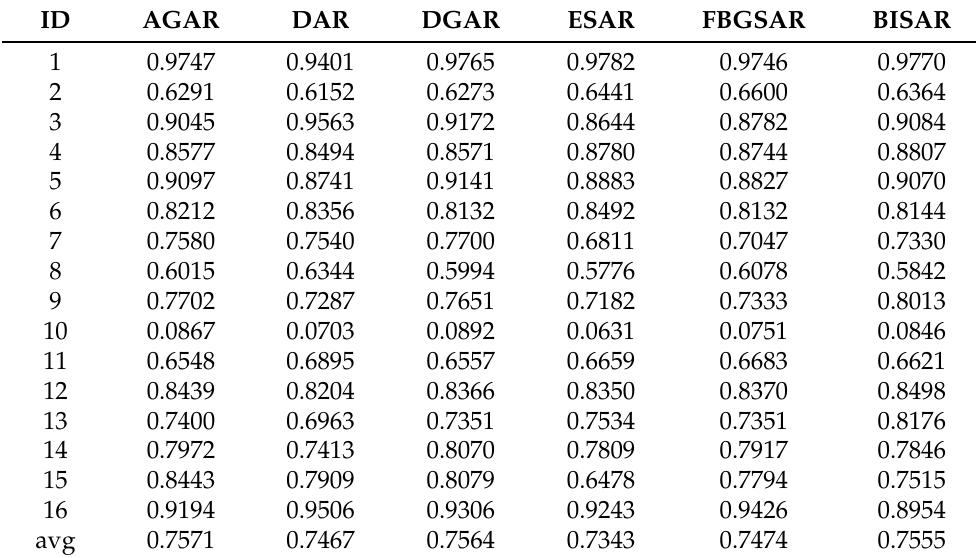
Table 8. Classification accuracies based on the KNN classifier (raw data).